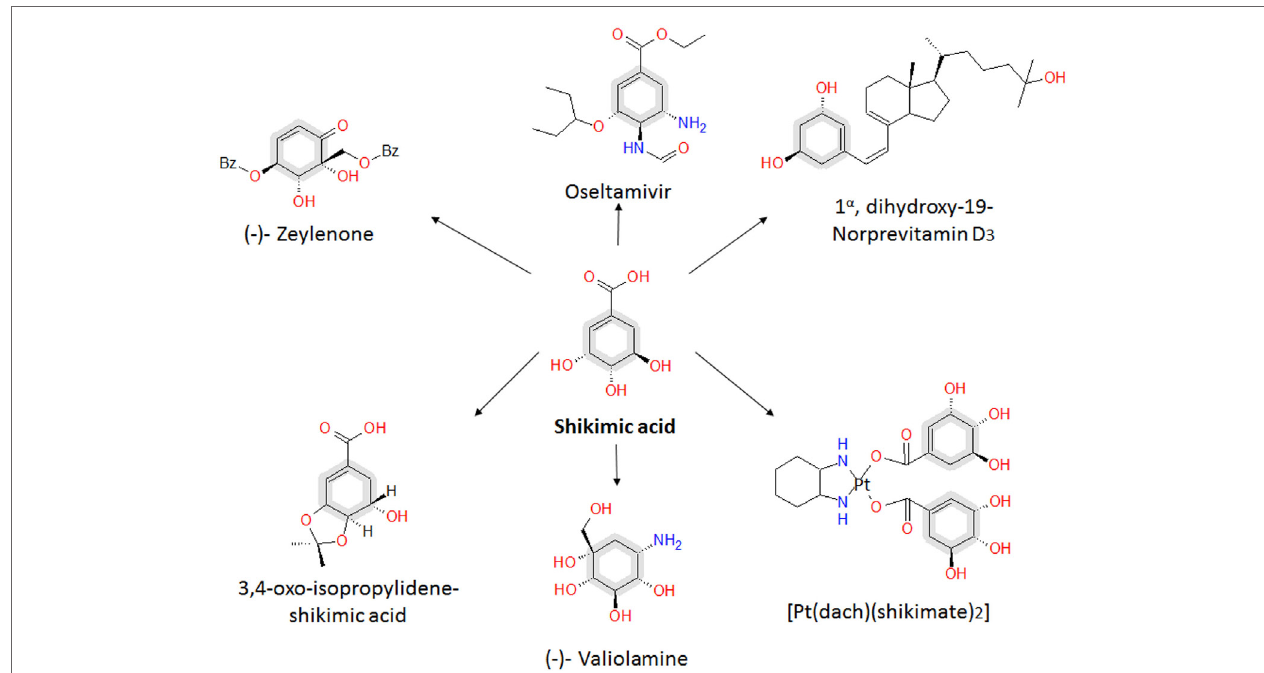
FiGURe 2 | Relevant SA derivatives with high added value . OSF, viral inhibitor of diverse influenza virus types, including seasonal types A and B, avian virus H5N1, and human virus H1N1. ( − )-Zeylenone is a compound with antiviral, anticancer, and antibiotic activities. ( − )-Valiolamine, a very strong α -glucosidase with inhibitory activity against porcine intestinal enzymes sucrase, maltase, and isomaltase. [PT(datch)(SA) 2 ] is an active compound against L1210 leukemia. 3,4-Oxo- isopropylidene-SA, with antithrombotic activity and anti-inflammatory effects. Analogs of 1 α , dihydroxy-19-Nor previtamin D3 is a compound with promising applications in the treatment of osteoporosis and malignancies. Adapted from Estevez and Estevez (2012) and Diaz Quiroz et al.